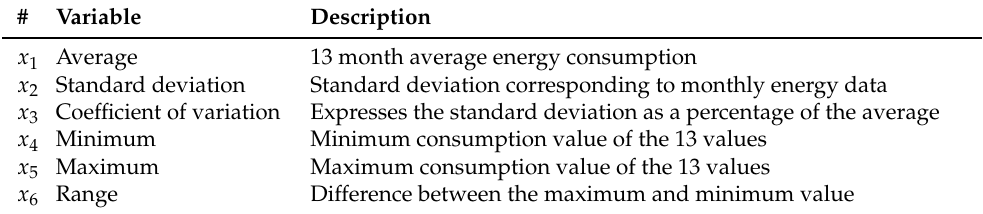
Table 6. Description of the